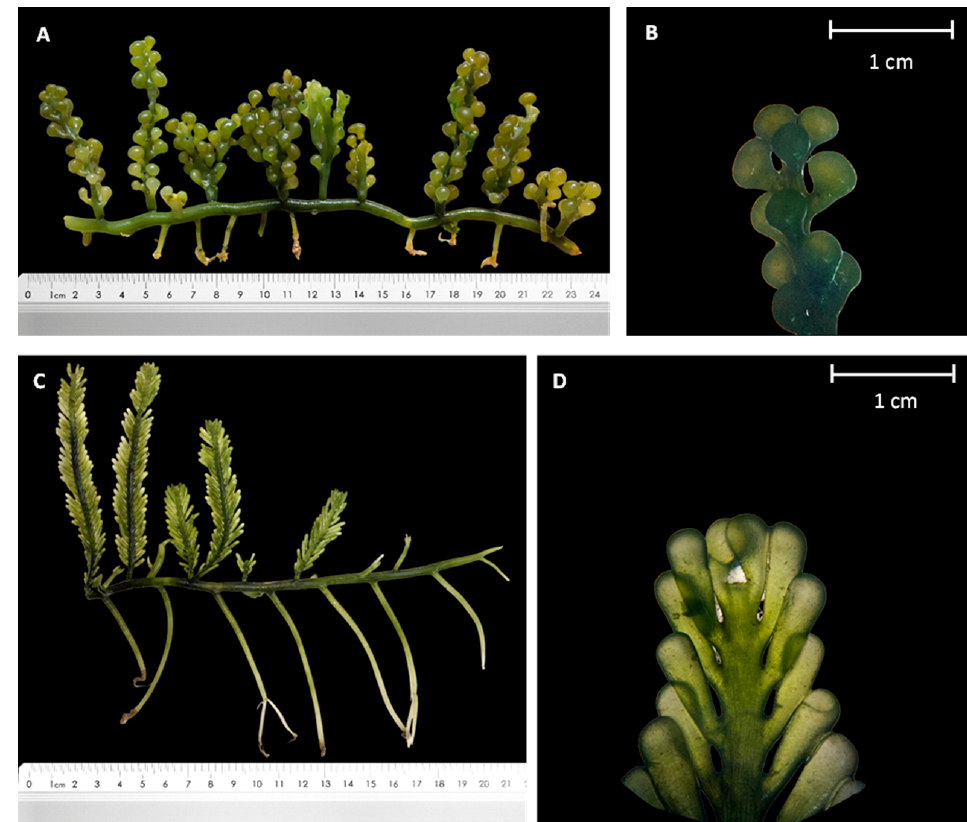
Figure 1. Morphological images of Bulung Anggur ( A , B ) and Bulung Boni ( C , D ).